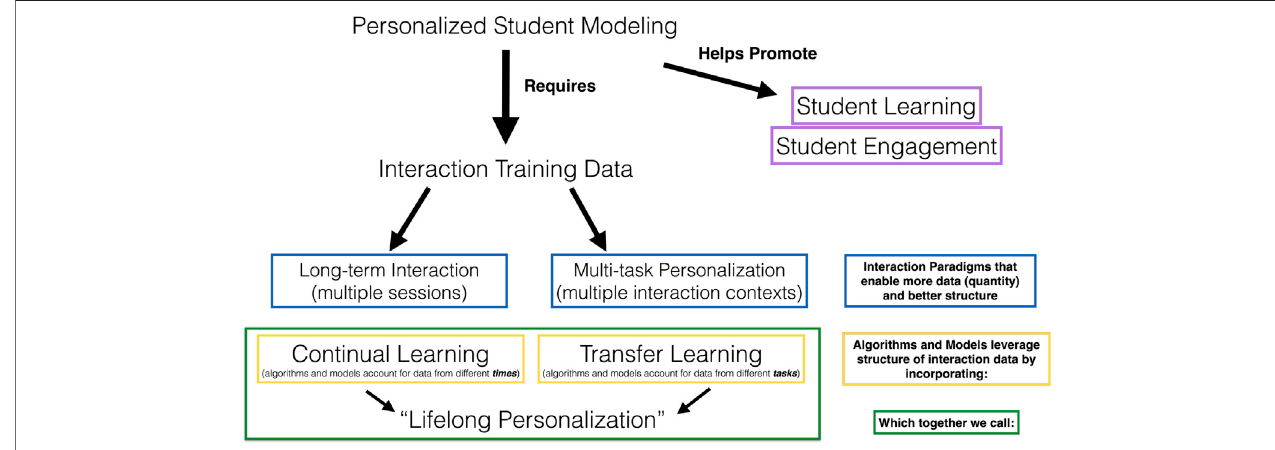
FIGURE 1 | Conceptual structure of terms and goals.